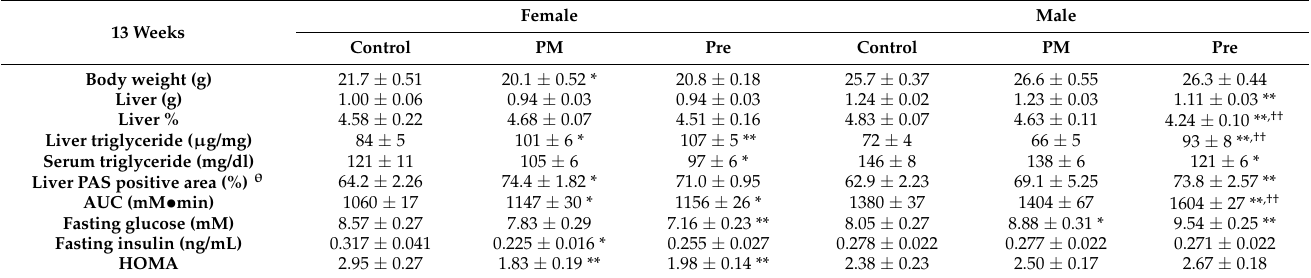
Table 2. Endpoint Measurements in the